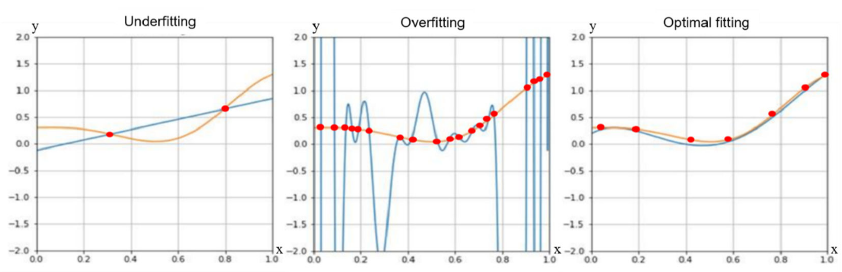
Figure 11. Underfitting, overfitting, and optimal